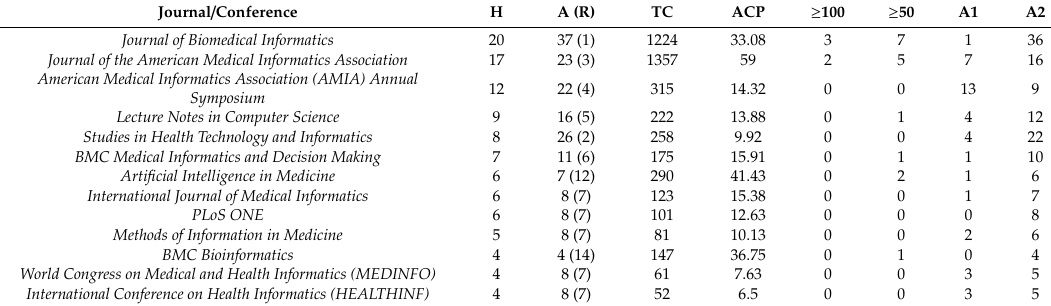
Table 5. Distribution of articles by publication source.